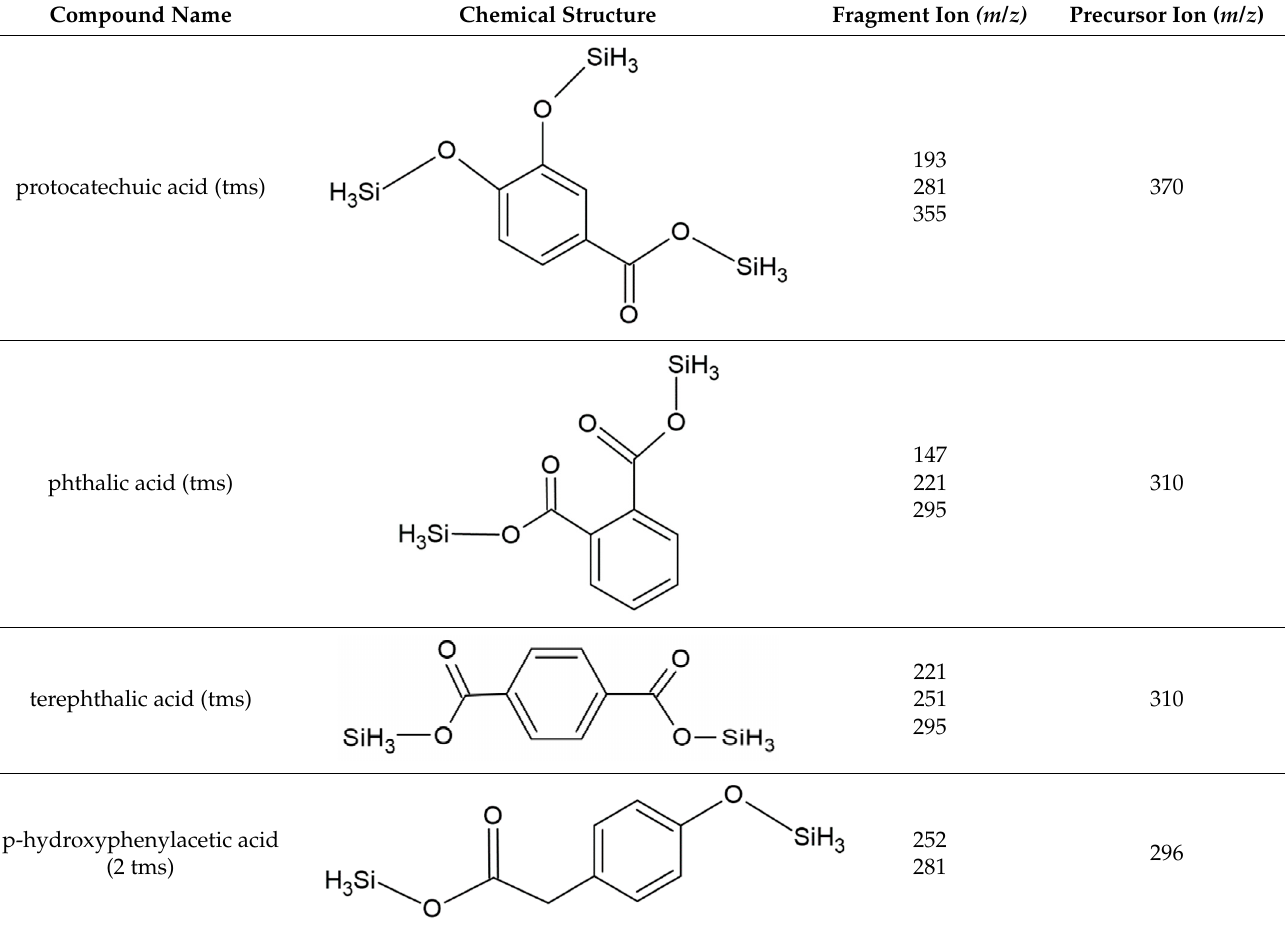
Table 2. Metabolites of degradation of PHE, B[a]A, and B[a]P obtained after N. pironii cultivation in the presence of leachate.